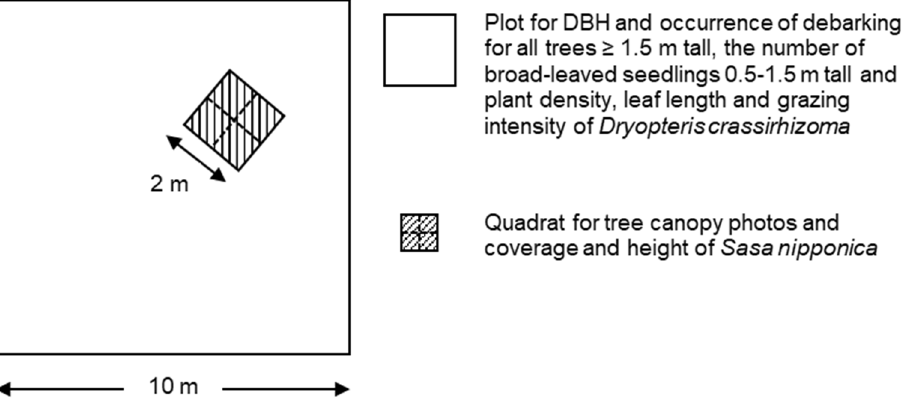
Figure 2. The arrangement of quadrat and subquadrats in each plot. Diameter at breast height (DBH), occurrence of debarking for all trees ≥ 1.5 m tall, and the number of broad-leaved seedlings 0.5–1.5 m tall and plant density, leaf length, and grazing intensity of Dryopteris crassirhizoma were recorded within plots. One 2 × 2 m quadrat was arranged in each plot randomly, and tree canopy photos and coverage and height of Sasa nipponica were recorded in each 1 × 1 m subquadrat.